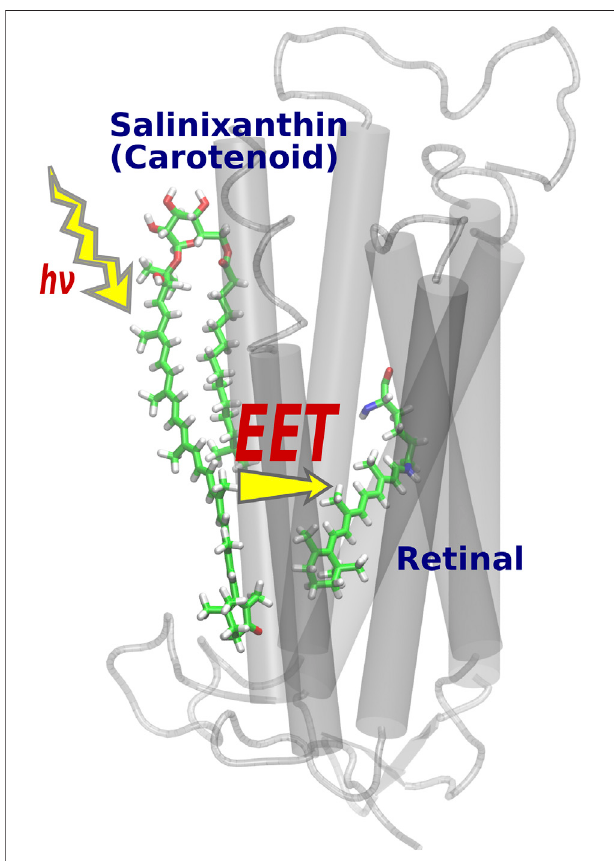
FIGURE 4 | Optimized structure of XR. After light absorption by the salinixanthin added on the protein surface, the retinal is excited via EET.